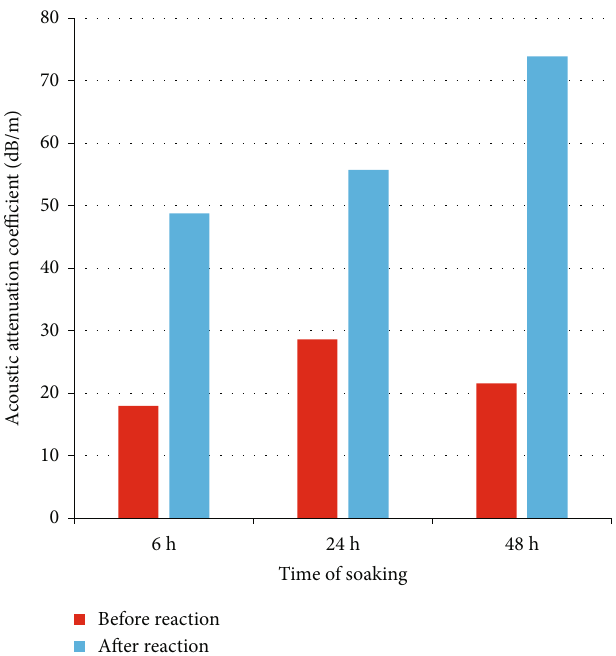
Figure 15: Acoustic attenuation coe ffi cient of shale before and after interaction with 5000mg/L NaCl solution for di ff erent